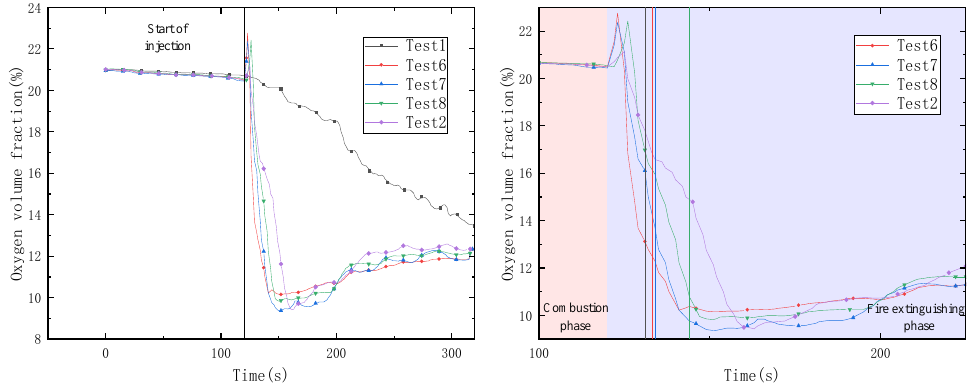
Figure 9. Comparison of oxygen volume fractions around the fire source.